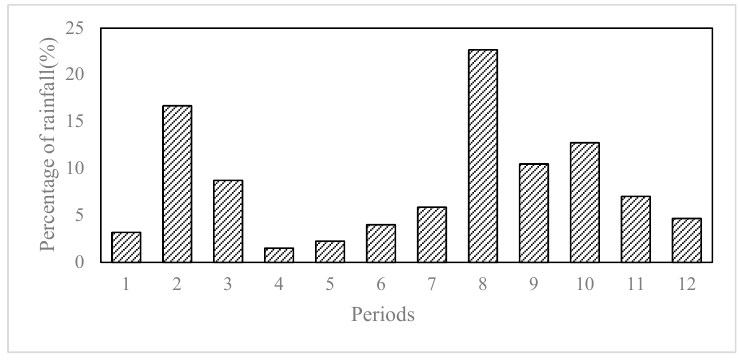
Figure 6. Rainfall distribution of the design hyetograph for scenario 3: combining single-peak and double-peak rainstorms.